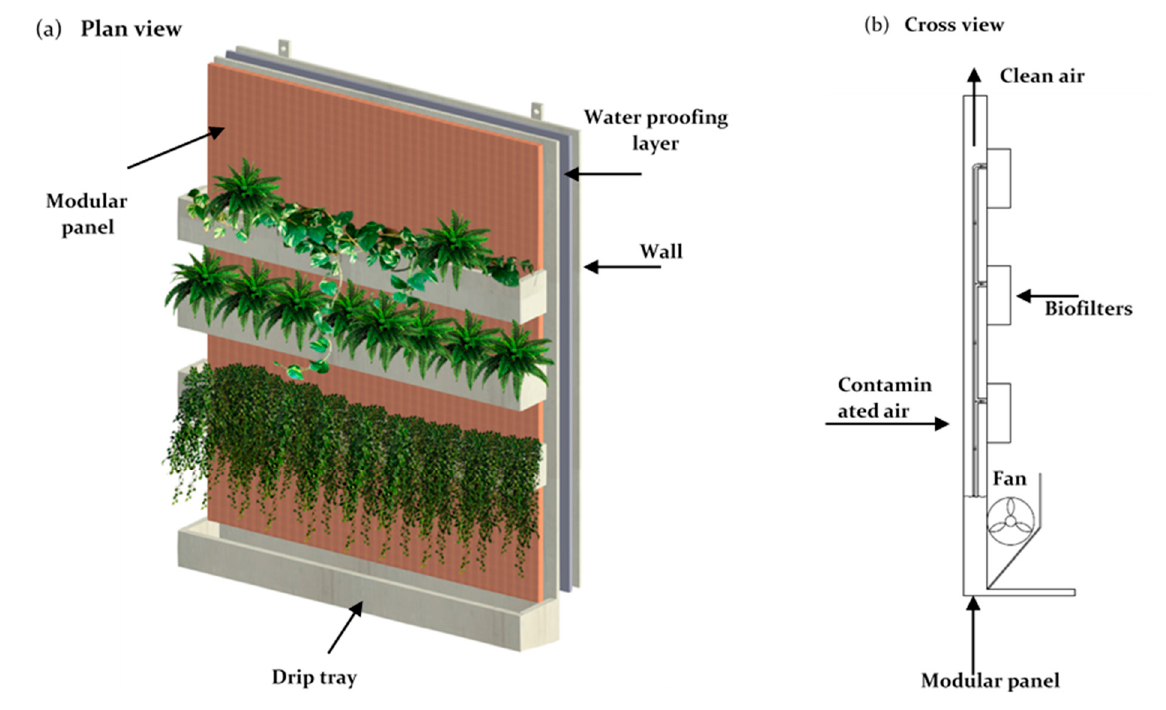
Figure 7. Prefabricated green wall: ( a ) plan view and ( b ) sectional view.